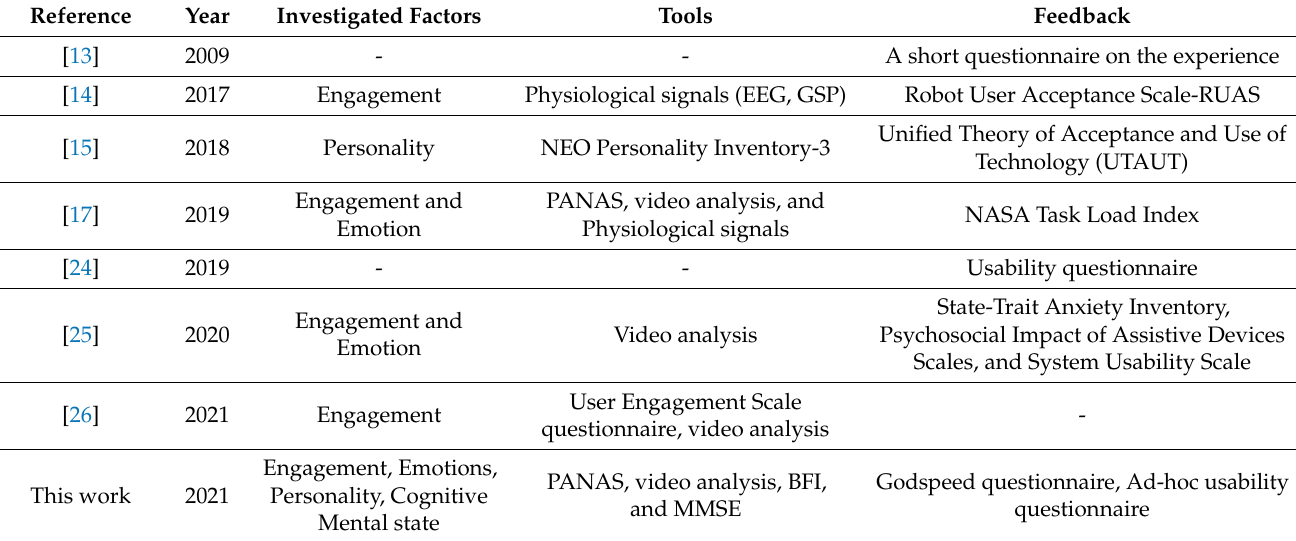
Table 2. List of investigated factors in previous socially assistive robotics (SAR)